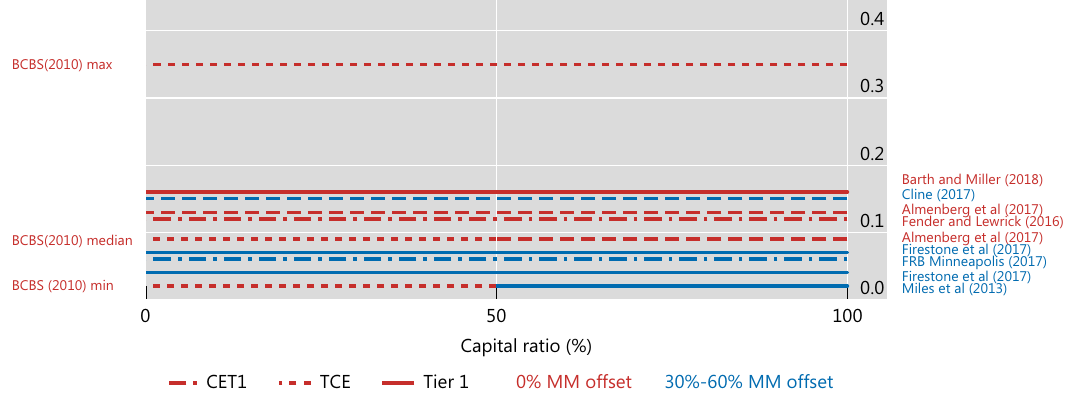
Figure 8. Marginal cost of higher capital requirements (per cent of annual GDP).